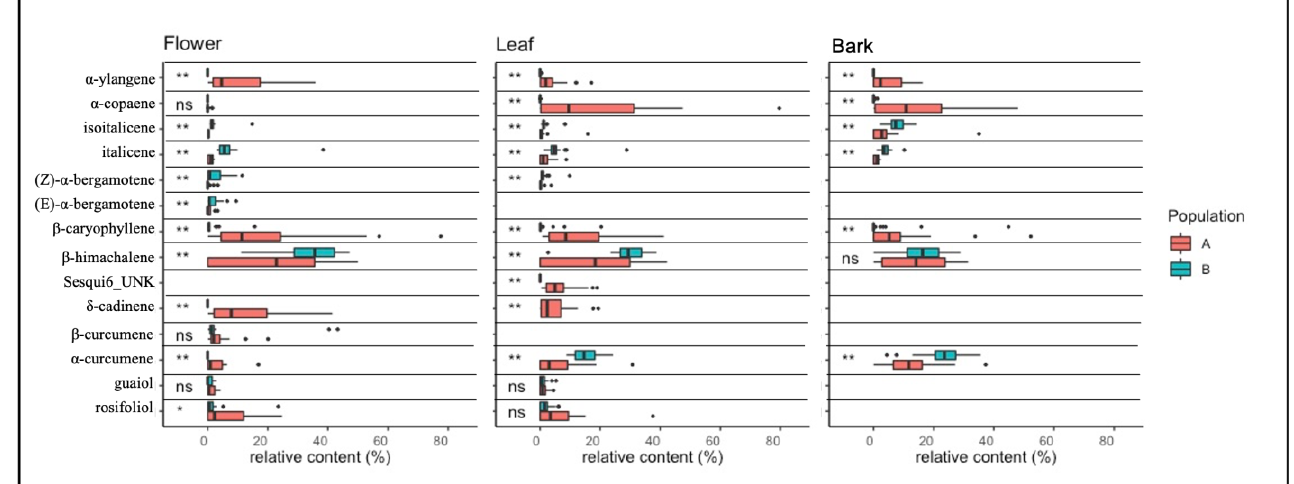
Figure 5. Boxplot and ANOVA of sesquiterpenes in flower, bark, and leaf tissues. Significance ANOVA codes are: (ns) for p > 0.05; (*) for 0.05 < p > 0.01; and (**) for p < 0.01. H. litoreum is reported in population A, and H. italicum subsp. italicum in population B.